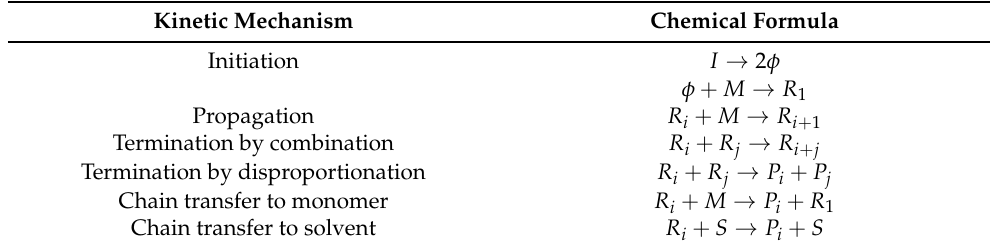
Table 1. Kinetic mechanism for PMMA